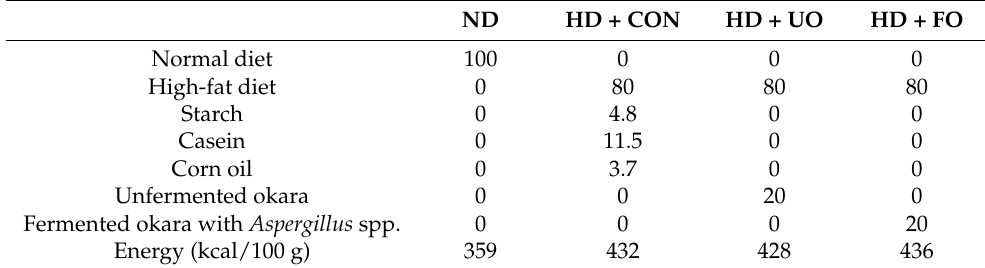
Table 3. Ingredient composition of diets (g/100 g).